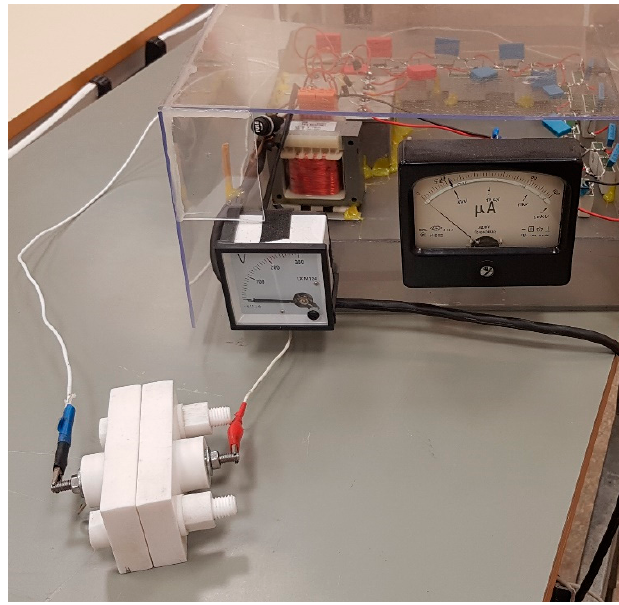
Figure 4. Pole alignment set.